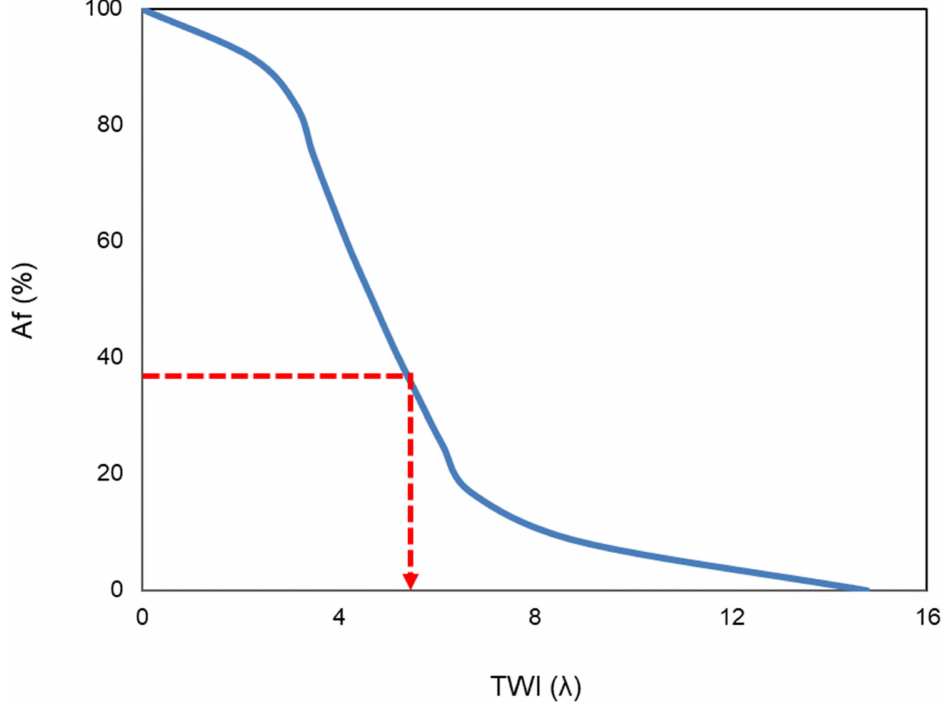
Figure 5. Distributed CN-VSA method—step 3: the relationship between A f (fraction of runoff generating area) and TWI (topographic wetness index) developed using TWI map to compute λ from A f determined in step